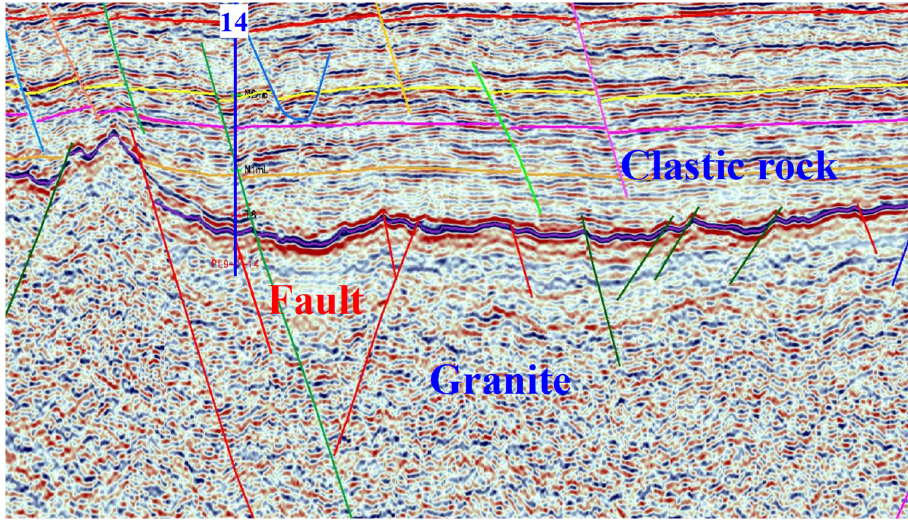
Figure 5. Seismic profile of Well 14 under the seismic sampling rate of 2 ms and the processing bin of 25 m × 12.5